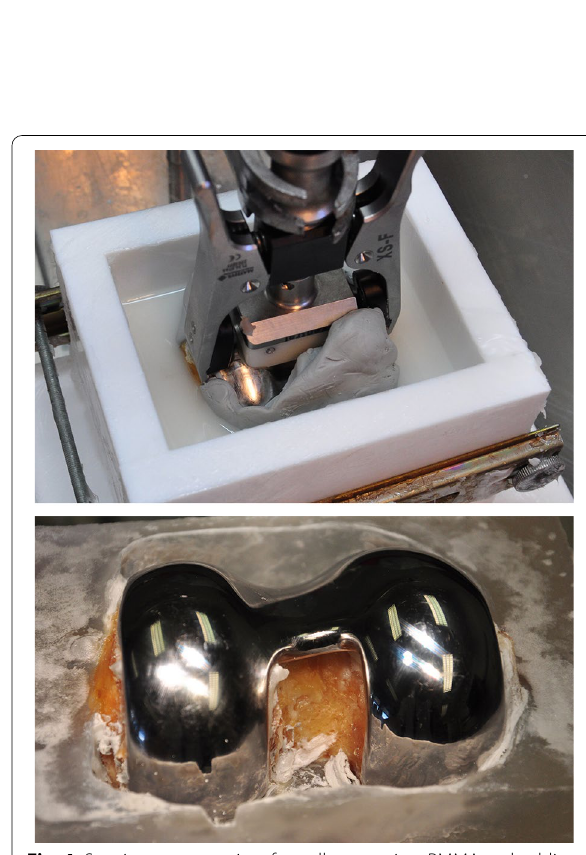
Fig. 4 Specimen preparation for pull-out testing. PMMA embedding of the femoral bone. Particular attention was paid on keeping the femoral component free of PMMA by using plasticine ( top ). Situation after plasticine removal ( bottom